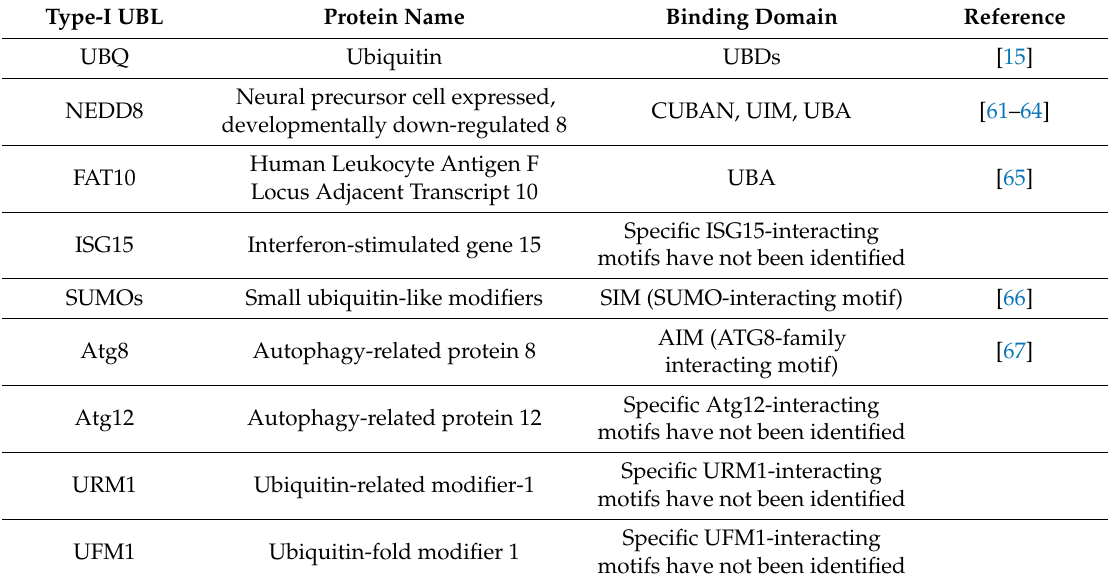
Table 1. Known ubiquitin-like proteins and the protein domains that specifically recognize